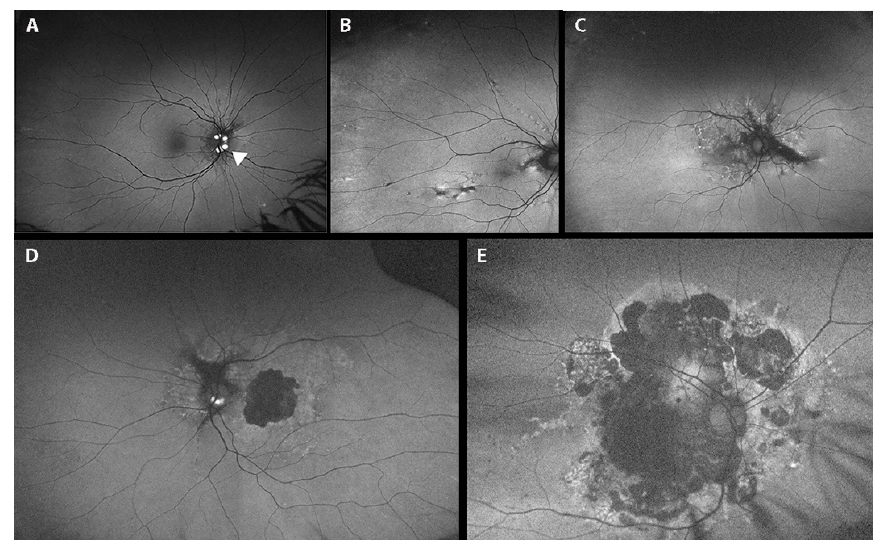
Figure 6. Fundus auto-fluorescence photographs ( A – E ) showing: ( A ) optic disk drusen (white arrowheads); ( B ) peripheral comet lesions; ( C ) pattern dystrophy like-changes as hyper/hypo-autofluorescent alterations; ( D ) pattern dystrophy-like changes with macular atrophy (central hypo-autofluorescence alteration); ( E ) posterior pole atrophy.